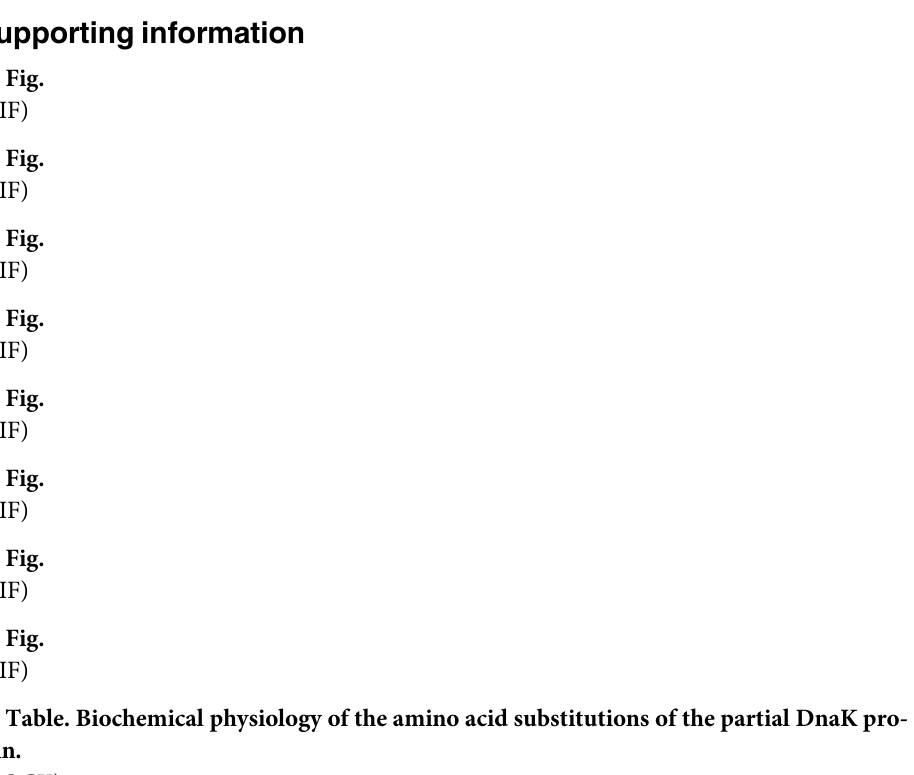
S1 Table. Biochemical physiology of the amino acid substitutions of the partial DnaK pro- tein. S2 Table. Mass spectrometry results for the partial DnaK protein of the Rhipicephalus annulatus tick. S3 Table. Analysis of discontinuous B-cell epitope predicted from the 3D structure of the partial DnaK peptide sequence determined in this study. S4 Table. High potential of the conserved region of the partial DnaK protein of CLE from R . annulatus for binding to candidate alleles of the MHC-I and MHC-II